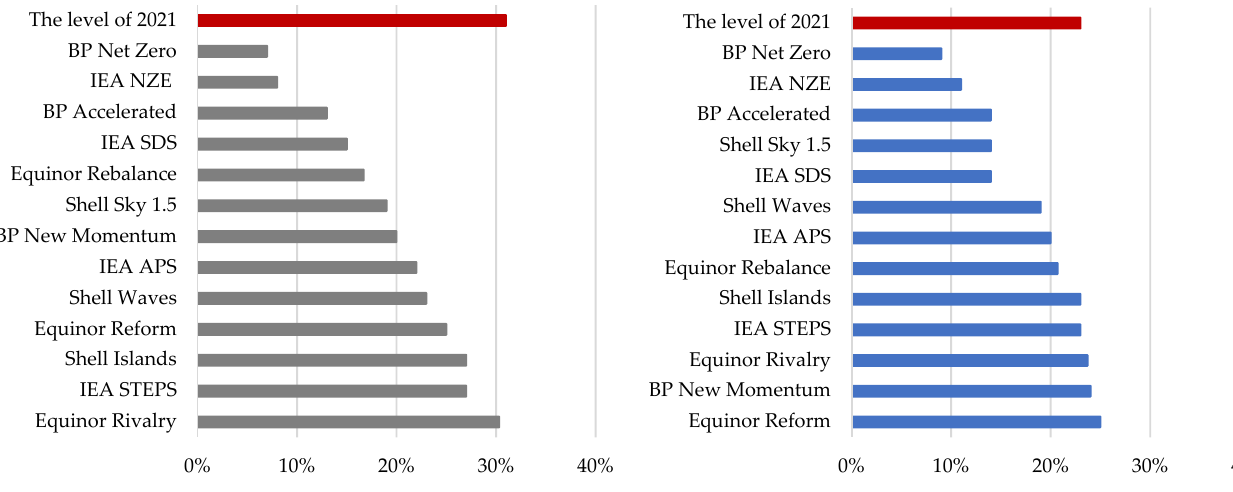
Figure 1. Forecast of the share of oil and natural gas in the world energy mix by 2050. Source: Created by the authors using data from [1,2,28,29].